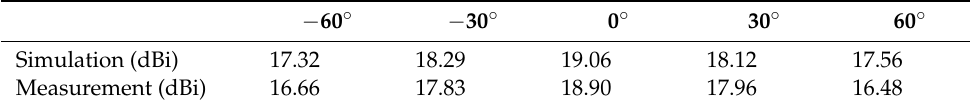
Table 2. Gain of the array at different scan angles.